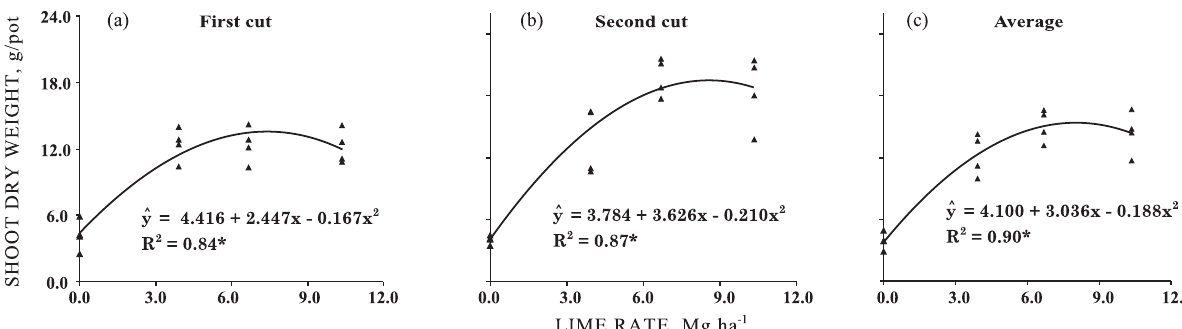
Figure 1. Effect of lime application on alfalfa shoot dry matter yield in first and second cut and on the average of both